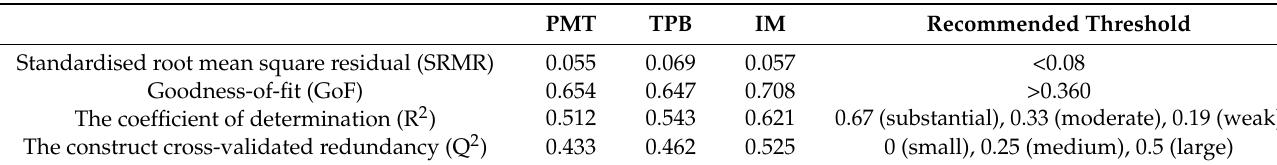
Table 4. Parameter values of the model fit.